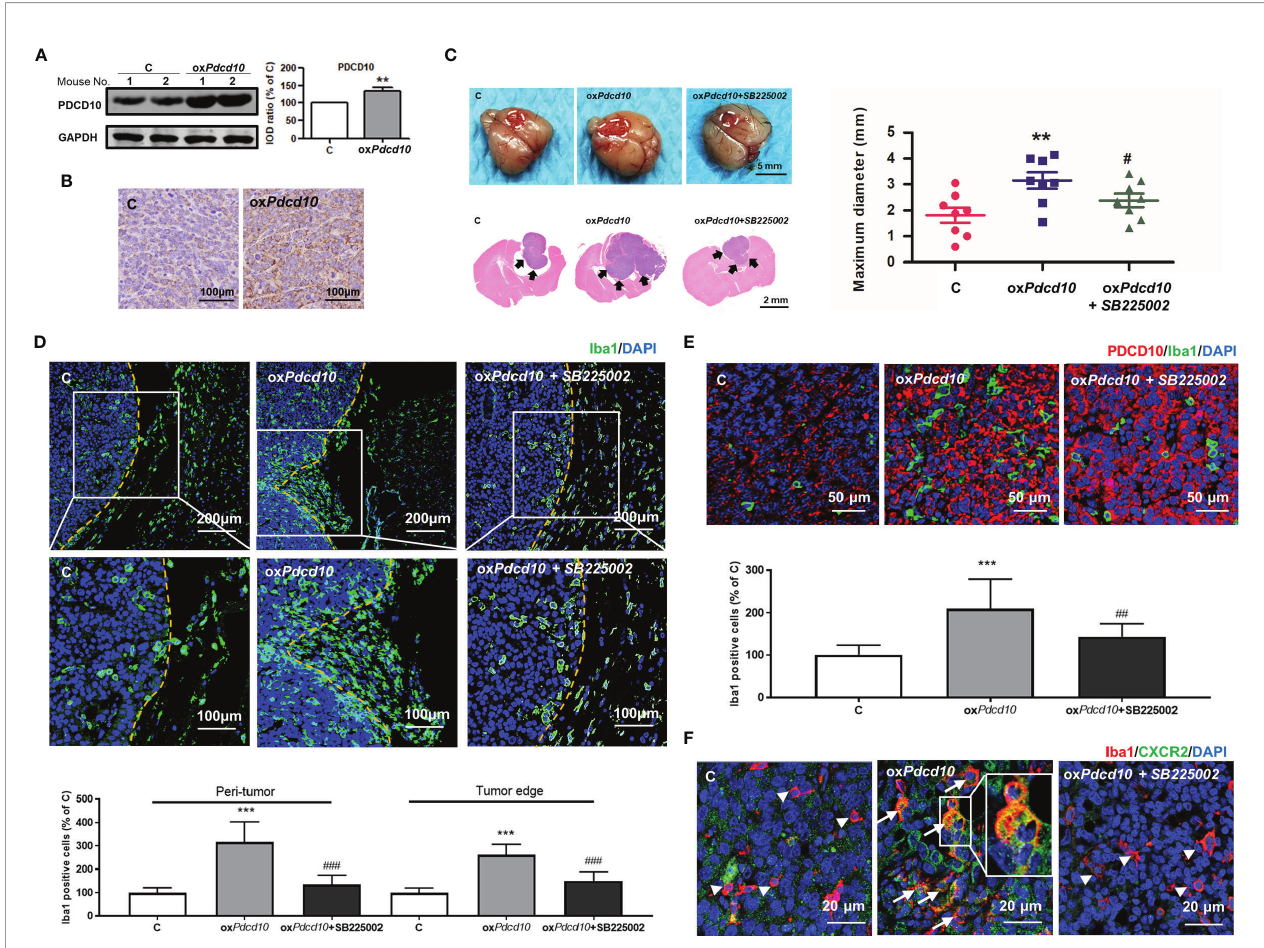
FIGURE 4 | Overexpression of Pdcd10 in murine GBM cells recruited microglia/macrophages and promoted tumor growth in vivo . Mice were cerebral orthotopic implanted with ox Pdcd10 - (ox Pdcd10 ) or control-GL261 cells (C) (n = 8 for each group). The whole brain was removed 28 days after implantation. (A) The stable PDCD10 overexpression was con fi rmed by Western blot. (B) Immunohistochemical staining demonstrated PDCD10 overexpression in homograft tumors. Scale bar = 100 m m. (C) Overexpression of Pdcd10 promoted homograft tumor growth, which was reversed by SB225002 treatment. Representative photos showed the homograft tumors (dot-line) in control-, ox Pdcd10 -mice, and SB225002 treated ox Pdcd10 -mice. Scale bar = 5 mm. HE-staining demonstrated that homograft tumor (arrows) in ox Pdcd10 group was larger than that in control group. After treatment with SB225002, the increase of tumor volume was reduced. (D) Pdcd10 overexpression in GL261 cells recruited microglia/macrophages, which was attenuated by SB225002 treatment. Substantial Iba1-positive cells (green) were detected in tumor edge and peri-tumor area (dot-line indicated tumor margin). The lower photos were the enlargement of white box in the upper images respectively. (E) Microglia/macrophages in fi ltration in tumor core induced by Pdcd10 overexpression was also attenuated by SB225002 application. Double-staining of PDCD10- (red) and Iba1 (green) in tumor core. Scar bar = 50 m m. (F) CXCR2 activation in microglia/macrophages mediated by Pdcd10 upregulation was abolished by SB225002 treatment. Immunoreactivity of CXCR2 (green) was merely detected in cells without Iba1-staining (red, arrowheads) in control mice. Co-labelling of Iba1 and CXCR2 (orange, arrows) was signi fi cantly detected in ox Pdcd10 -tumors. The box (middle photo) was magni fi ed to show the co-localization of CXCR2 and Iba1. Scar bar = 20 m m. **p<0.01 and ***p<0.001, compared with C, # p < 0.05, ## p < 0.01 and ### p < 0.001, compared with ox Pdcd10